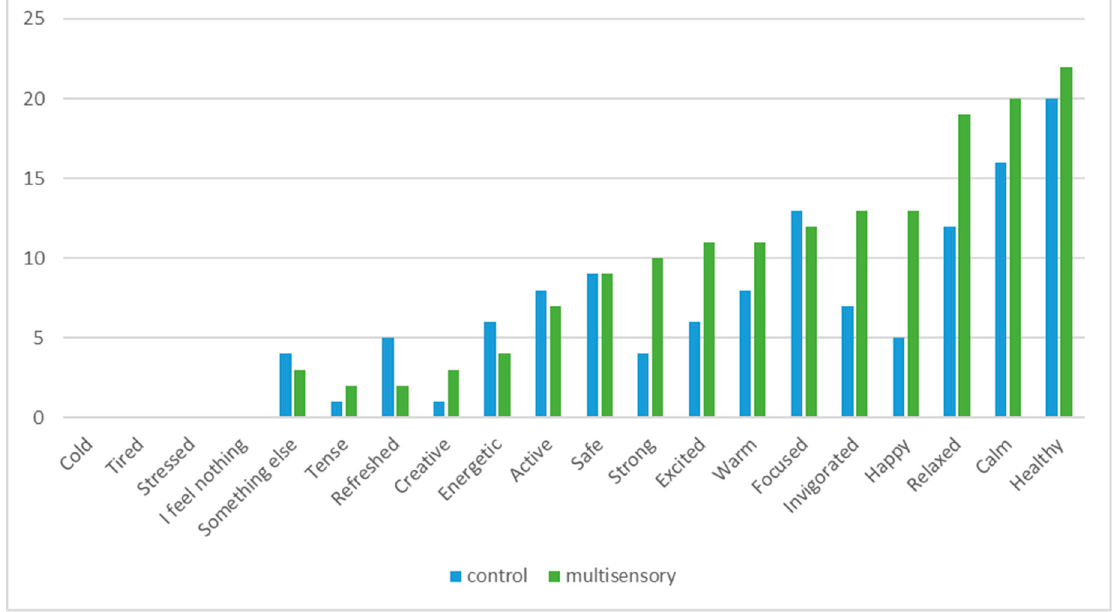
Figure 4. Selection of the emotion terms (n) in different conditions.